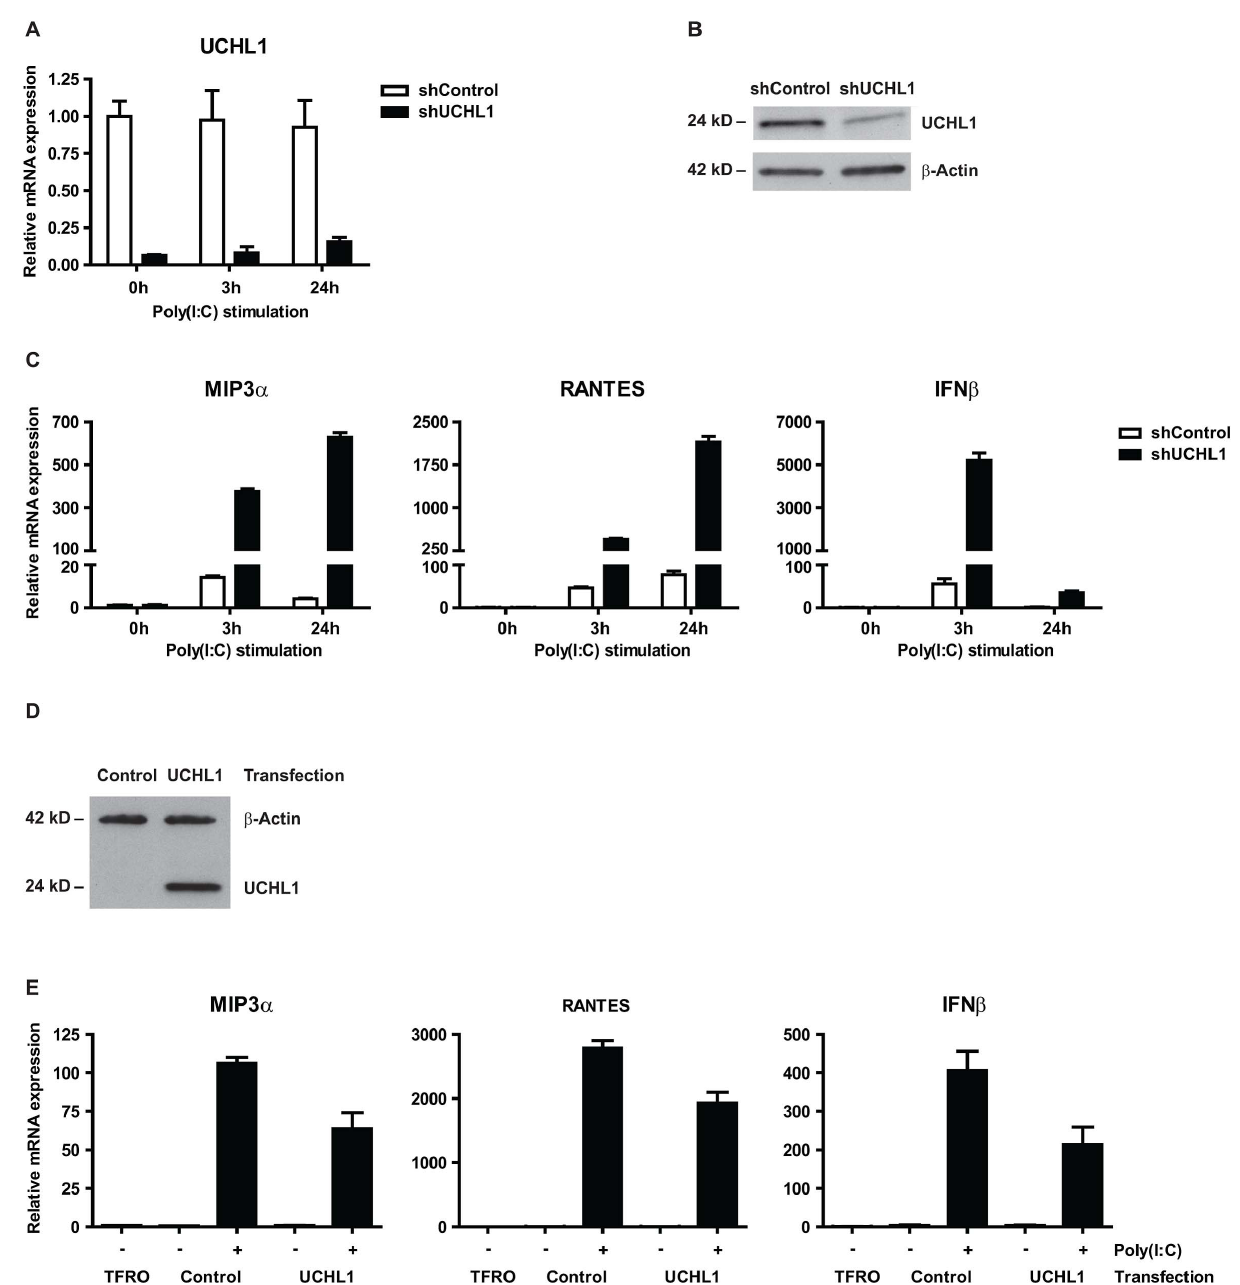
Figure 5. UCHL1 is responsible for suppressing poly(I:C) mediated gene activation of IFN-I and proinflammatory cytokines in hrHPV-infected KC. ( A – C ) UCHL1 knock-down effect of poly(I:C) mediated gene expression of IFN-I and proinflammatory cytokines. HPV16 + keratinocytes were transduced with lentiviral vectors expressing shRNA against control mRNA (TurboGFP; shControl) or targeting mRNA of UCHL1 (shUCHL1). Cells were either left unstimulated, or were stimulated with poly(I:C) for 3 or 24 hrs. ( A ) UCHL1 mRNA expression was analyzed by qRT-PCR and ( B ) UCHL1 protein levels were analyzed by western blotting in whole cell extracts, b -actin served as loading control. ( C ) MIP3 a , RANTES and IFN b mRNA expression was analyzed by qRT-PCR. Gene expression was normalized against GAPDH mRNA levels and standardized against 0 h of stimulation with poly(I:C). ( D , E ) UCHL1 overexpression effect on the activation of poly(I:C) mediated gene expression of IFN b and proinflammatory cytokines. Uninfected keratinocytes were transfected with a vector harboring the UCHL1 gene, an empty control or only received the transfection agent (TFRO). Cells were either left unstimulated, or were stimulated with poly(I:C) for 24 hrs. ( D ) UCHL1 protein levels were upregulated in the UCHL1 -transfected cells as detected by western blotting in whole cell extracts, b -actin served as loading control. ( E ) MIP3 a and RANTES mRNA expression was analyzed by qRT-PCR. Gene expression was normalized against GAPDH mRNA levels and standardized against the TFRO at 0 h of stimulation with poly(I:C).